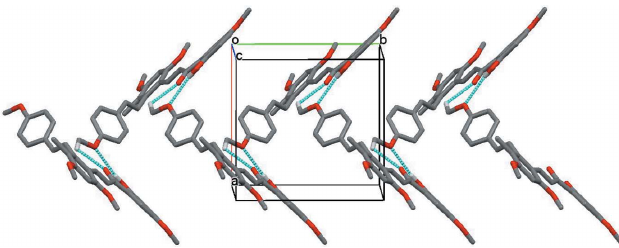
Figure 3 Part of the crystal structure of (I) with hydrogen bonds (blue dashed lines) shown. For clarity only those H atoms involved in hydrogen bonding are shown.